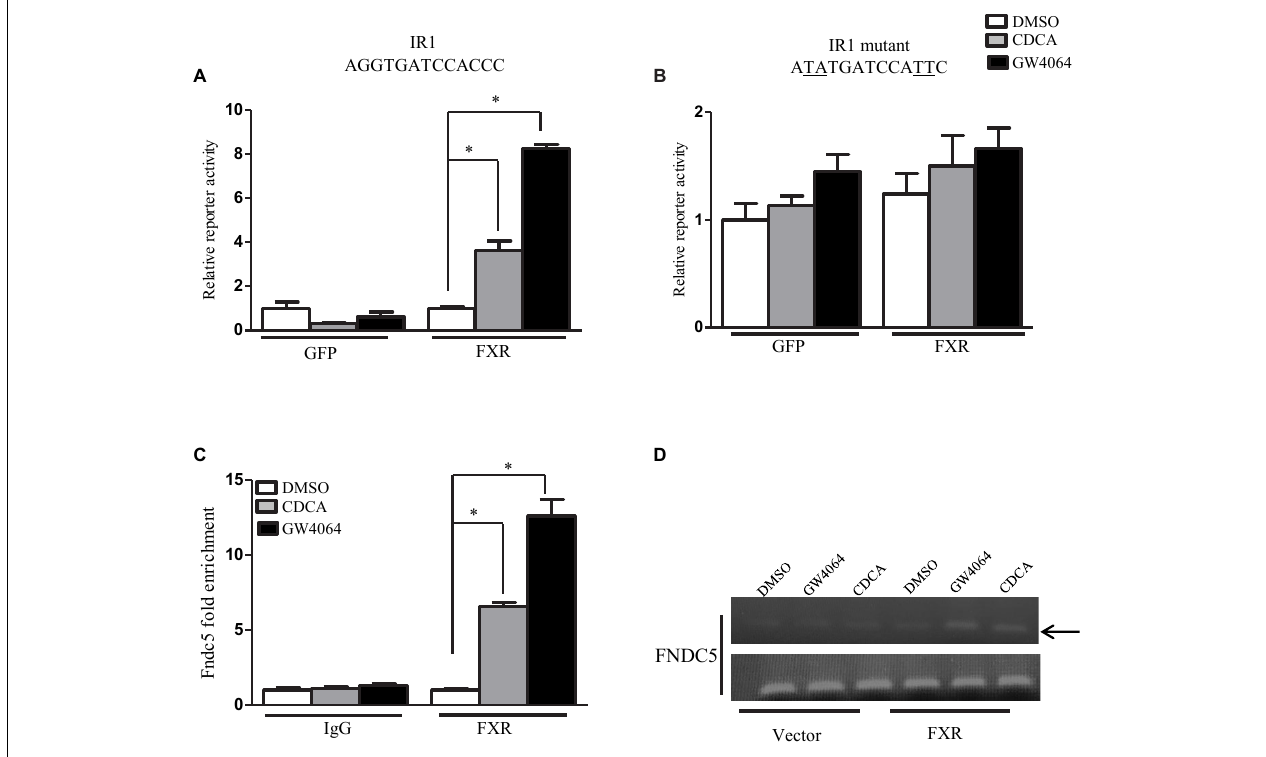
FIGURE 2 | Fibronectin type III domain-containing protein 5 (FNDC5) is transcriptional target gene of FXR. (A,B) Luciferase assay of transient transfection in HEK293T cells with the FNDC5 natural and mutant promoter reporter ( n = 3). (C) HepG2 cells were transfected with or without FXR vector, then treated with CDCA (100 µ M) or GW4064 (2.5 µ M) for 24 h. ChIP was performed with anti-FXR antibody ( n = 3). (D) The relative band intensity of PCR products revealed the recruitment of FXR to FNDC5. Data are mean ± SEM. ∗ P <